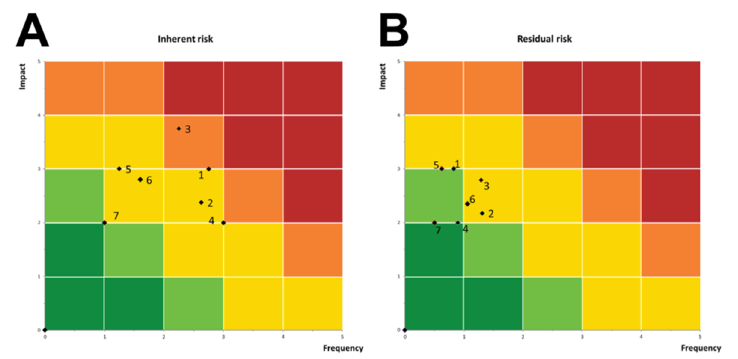
Figure 2. The Figure present the obtained risk scenarios according to their inherent risk (( A ), left matrix) and residual risk (( B ), right matrix) profile. Impact of risks is plotted on the y-axis while frequency of risks is plotted on the x-axis. Both use a one to five scoring scale with one being the lowest and five being the highest. (1) Impaired confidentiality; (2) Unusability of cryopreserved biological material; (3) Accidents of researchers, employees or technicians in laboratories and cryogenic rooms; (4) Infringement of the rules on the conservation of biological material; (5) Prolonged interruption of BioBank activities; (6) Compromise of the value of the biological sample; (7) Loss of data related to samples.